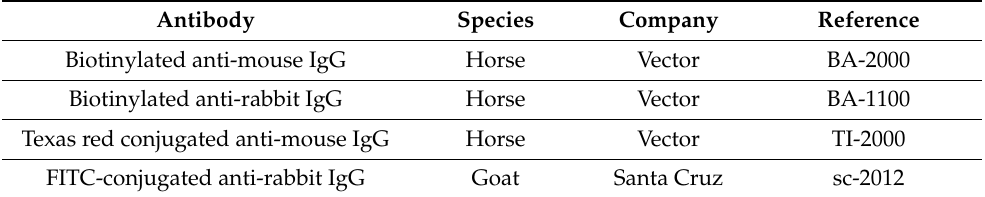
Table 2. Secondary antibodies used in this